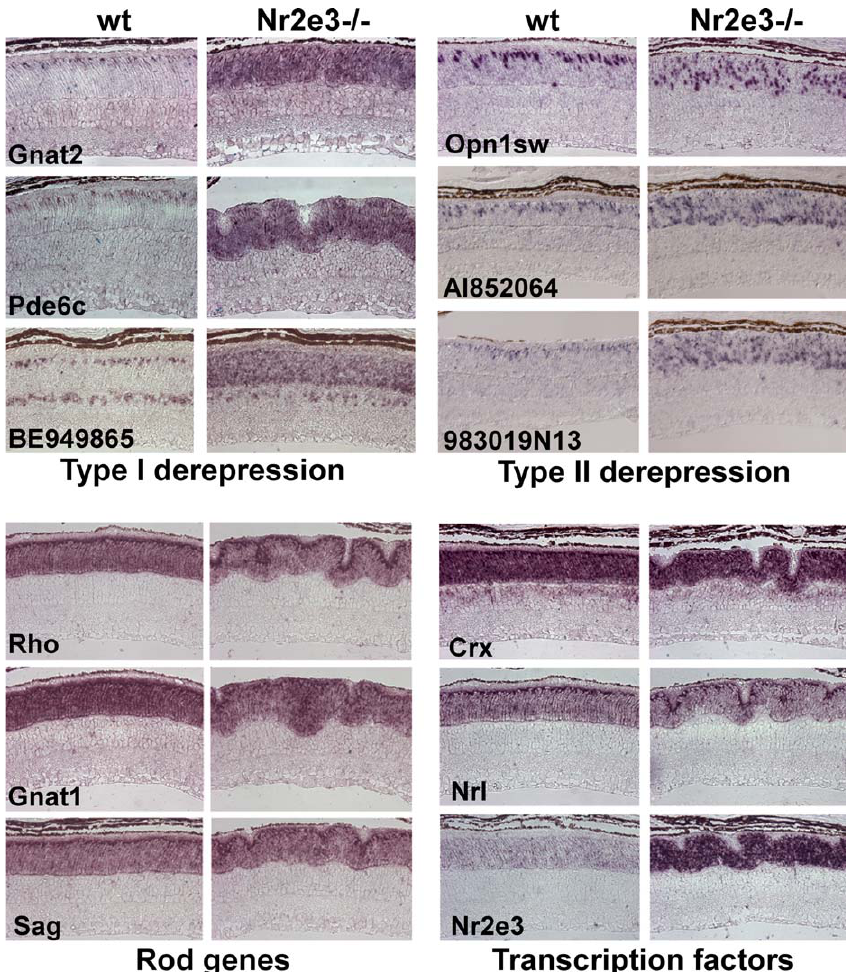
Figure 2. Cone and Rod Gene Expression in the rd7 Mutant at P14 The upper sets of photomicrographs demonstrate examples of type I and type II cone gene derepression in the rd7 mutant retina as explained in the main text. The bottom left images show several rod-specific genes that are essentially unchanged in the rd7 background at P14. The bottom right images show the expression pattern of three photoreceptor transcription factors in the rd7 mutant. Abbreviations in the lower left hand corner of each pair of panels represent the gene symbols summarized in Figure 1. DOI: